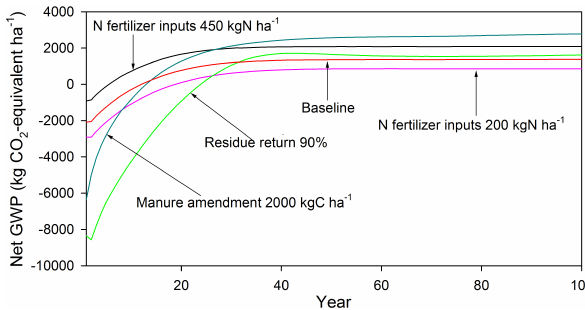
Fig. 9. Influence of management practices on long-term N 2 O fluxes.